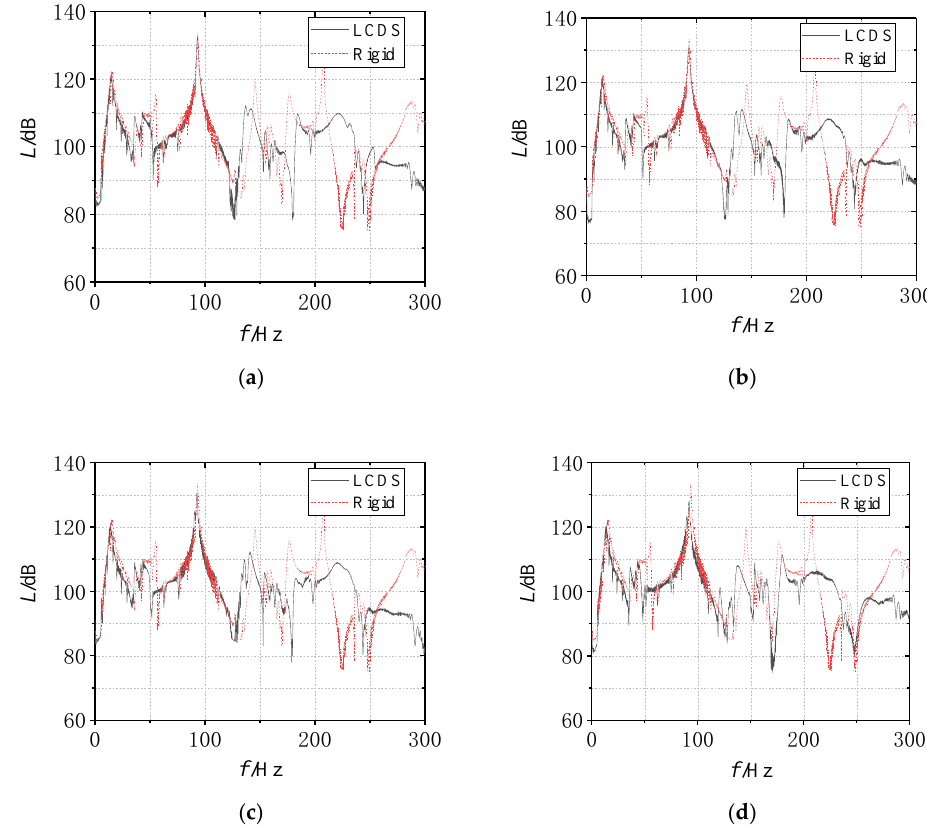
Figure 18. Vibration response curve of pipeline with different coated length: ( a ) 200 mm; ( b ) 500 mm; ( c ) 750 mm; ( d ) 1000 mm.